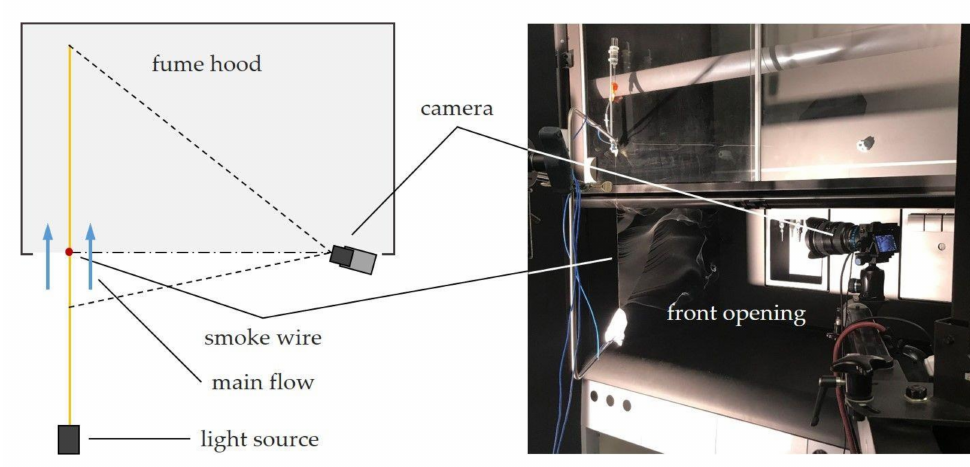
Figure 14. Experimental setup for flow visualization with the smoke wire.